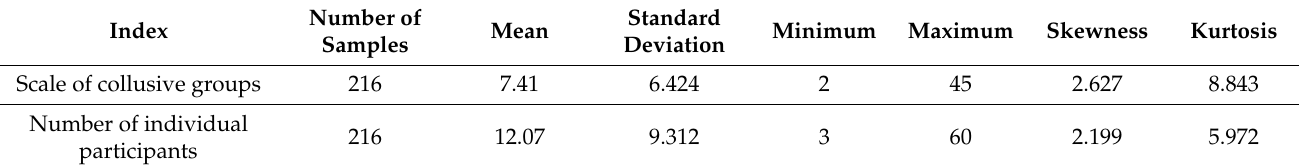
Table 1. Descriptive statistics of the number of collusive groups and participants.